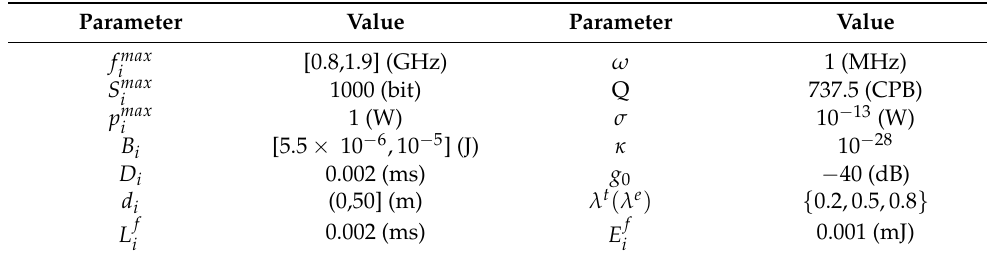
Table 2. Parameters and